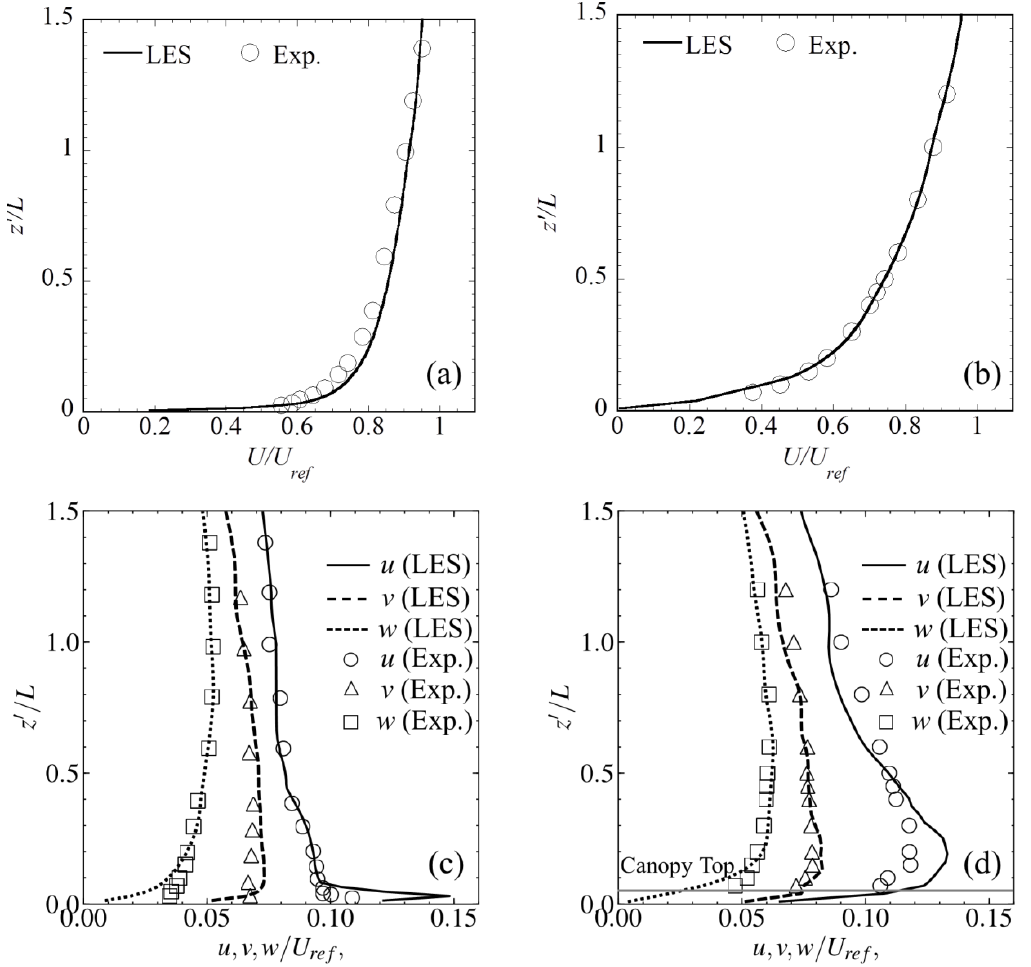
Figure 3. Comparison of the mean streamwise velocity over ( a ) smooth ground, and ( b ) rough ground,